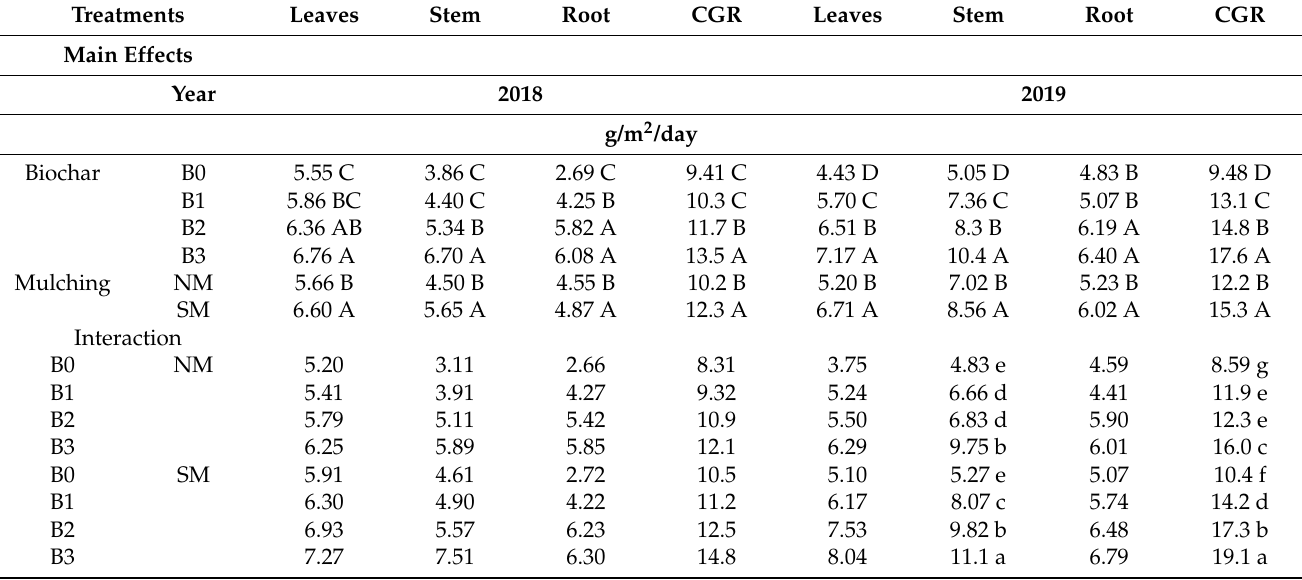
Table 5. Interactive impact of straw mulch and biochar application rates on the leaves, stem, root growth rate, and crop growth rate (g/m 2 /day) of the maize